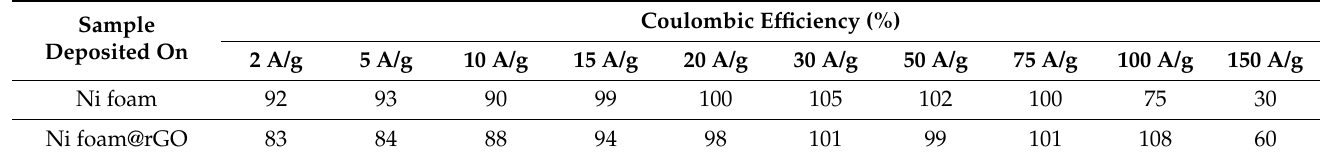
Table 1. Coulombic efficiency of the Co x NiV y O z films deposited on the various